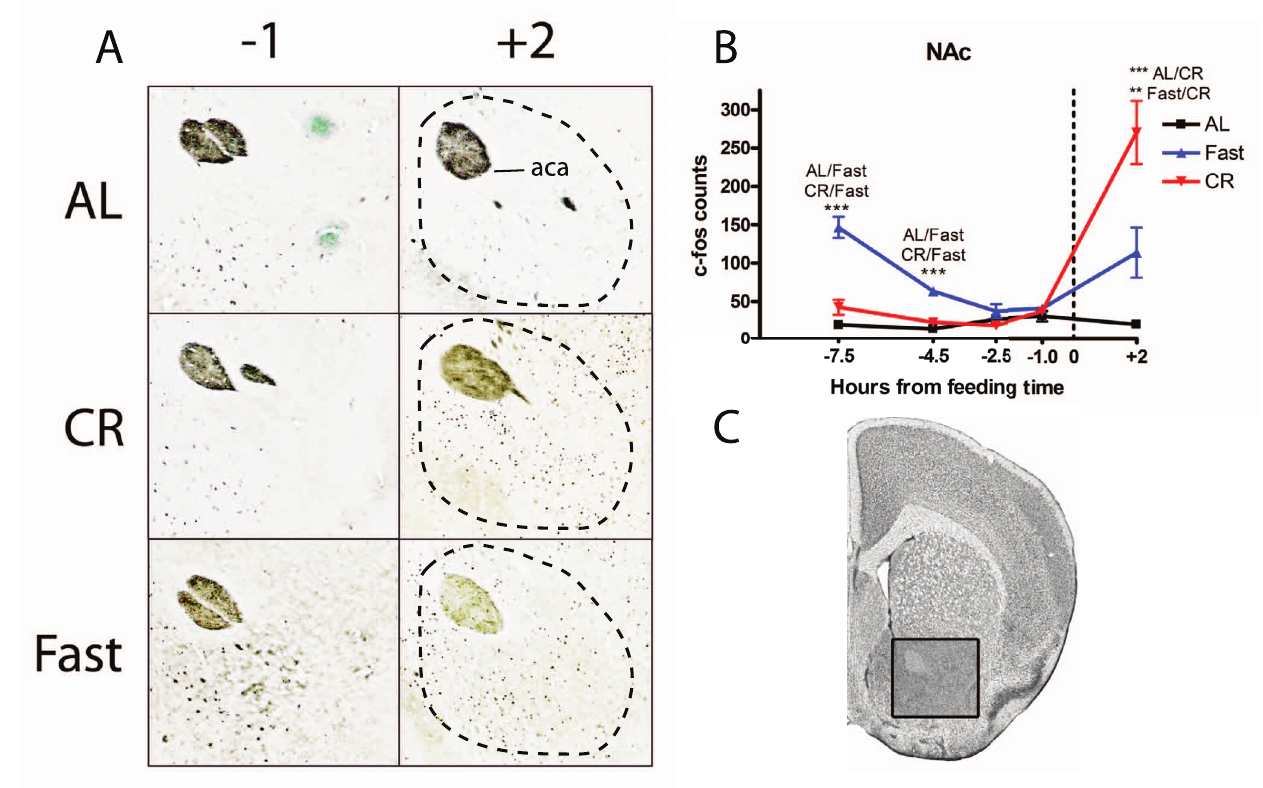
Figure 7. c-Fos protein expression in the in the nucleus accumbens core (NAc Core) of calorie-restricted, acutely fasted, and AL control mice. (A) Representative micrographs of c-Fos staining in the core of the nucleus accumenbs at TP 2 1 and + 2. (B) Mean ( 6 SEM) number of c-Fos-immunoreactive nuclei in the NAc Core of AL, fasted, and CR mice at 5 time points measured relative to feeding. (C) Representative coronal brain map with Nissl stain showing location of region under study. (Adapted from Paxinos and Franklin). Sample sizes for TP 2 7.5 thru + 2 are n=4, 8, 8, 6, 4 for AL groups, n=4, 8, 8, 6, 4 for CR groups, and n=4, 4, 4, 4, 4 for Fast groups.